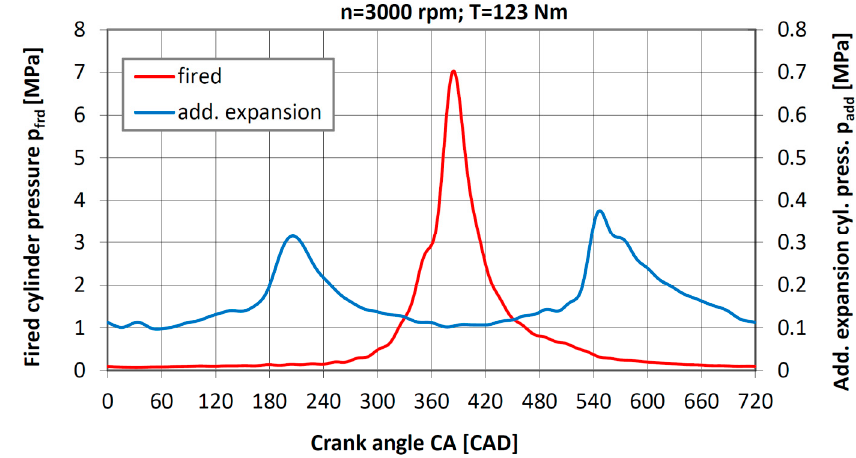
Figure 9. Chart in a p-CA for the fired cylinder and additional expansion cylinder recorded at 3000 rpm and a torque equal to 123 Nm.